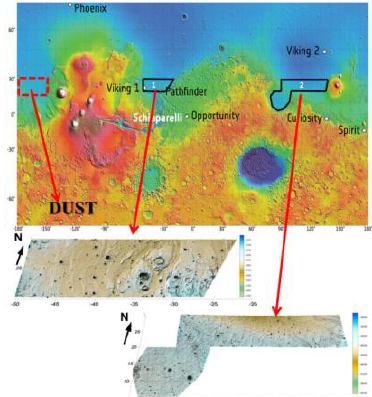
Figure 2. Primary selected landing sites (MOLA Elevation)